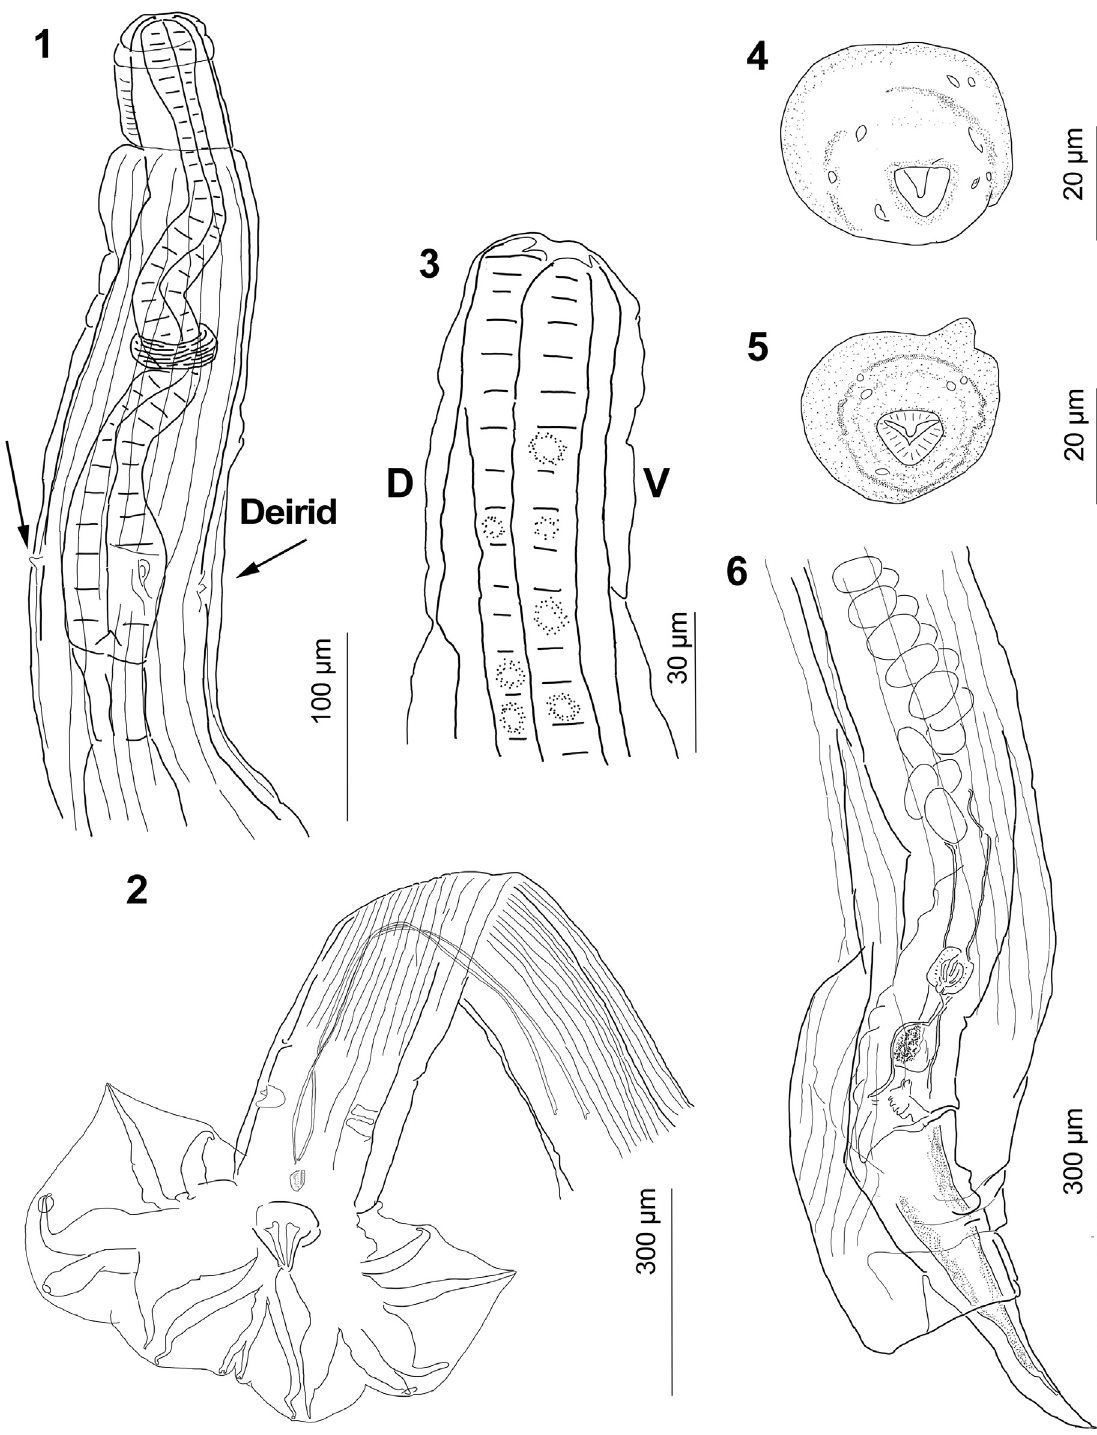
Figures 1–6. Guerrerostrongylus marginalis n. sp. 1, Ventral view of the anterior end of male, showing cephalic vesicle, esophagus, nerve ring, deirids (indicated by arrows), and excretory pore (between deirids). 2, Posterior end of a paratype, showing caudal bursa, genital cone, and spicules. 3, Lateral view of cephalic vesicle and stoma with esophageal tooth (upper left) not projected toward lumen. 4, Apical view of a female featuring dorsal tooth and triangular stoma. 5, Apical view of a male, showing dorsal tooth and triangular stoma. 6, Posterior end of a paratype showing cuticular invagination covering vulva, vulva, anus, ovejector, infundibulum, eggs in uterus, and